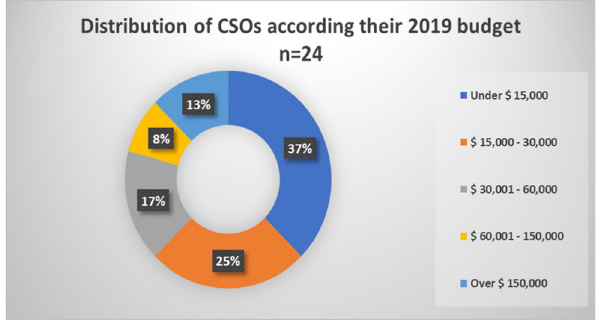
Figure 4: Distribution of the organizations participating in the study according to their 2019